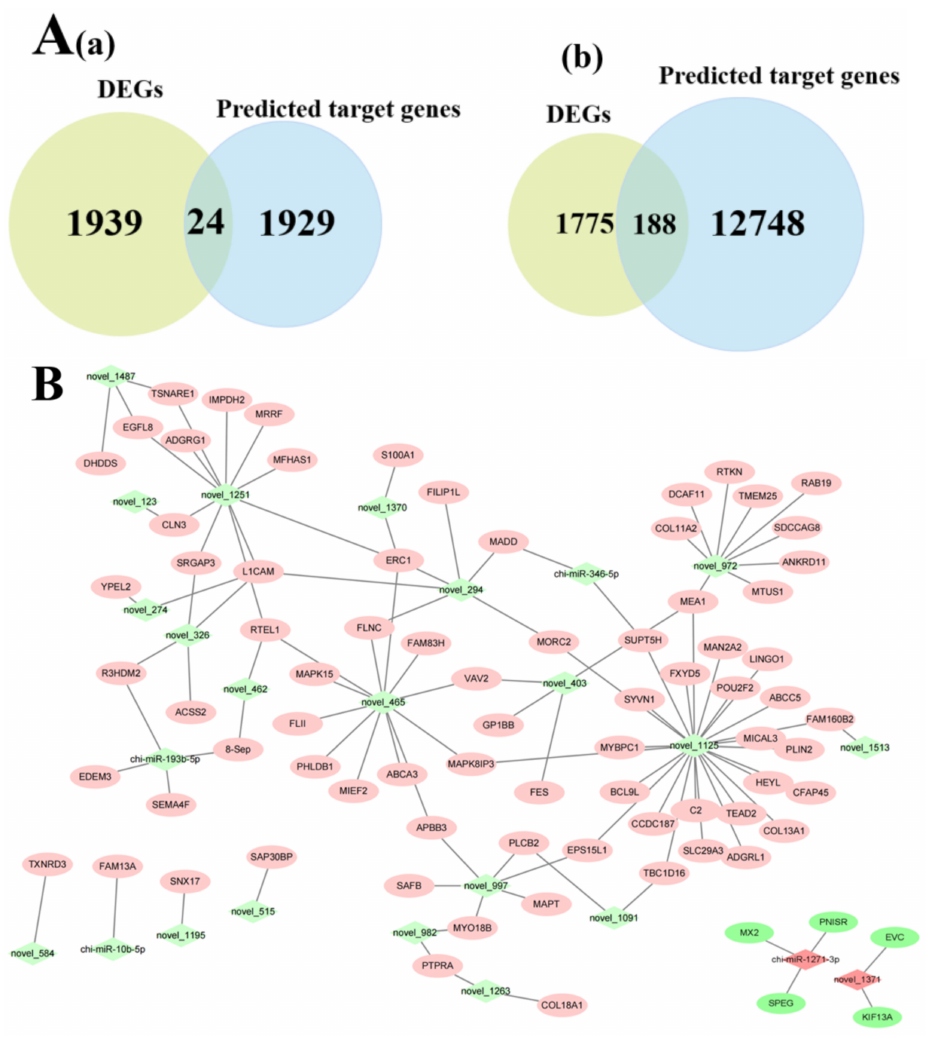
Figure 7. Overview of the mRNA-miRNA networks. ( A ) ( a ) Intersected genes in the LP-HF vs. LP-LF between the DEGs and the predicted target genes by the known miRNAs. ( b ) Intersected genes in the LP-HF vs. LP-LF between the DEGs and the novel miRNA-targeted genes. ( B ) Main hypothalamic interaction network in the LP-HF vs. LP-LF. Table 4. GO terms related to the miRNA-mRNA co-expression network